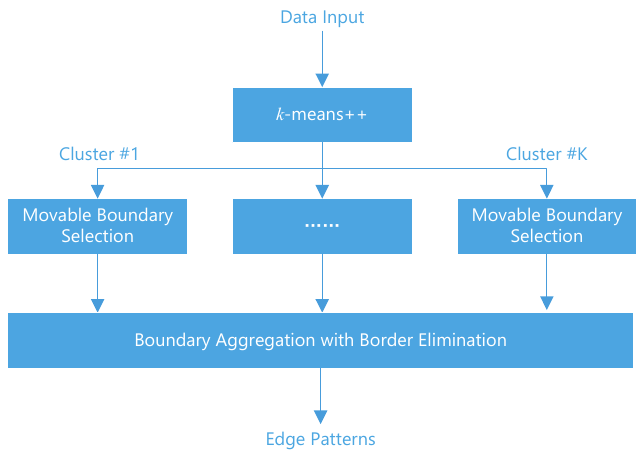
Figure 1. Framework of